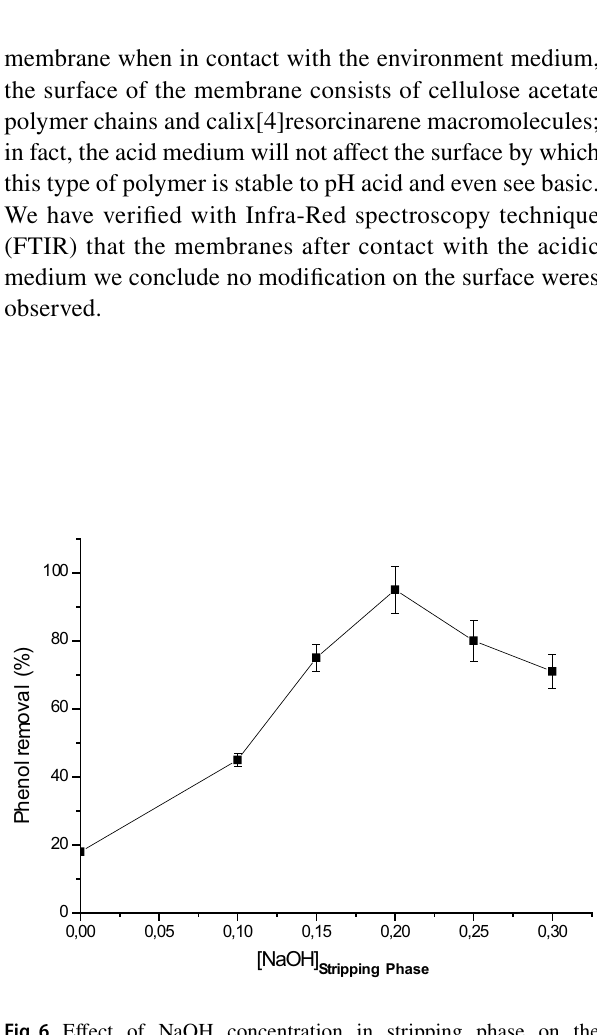
Transport conditions: feed phase: phenol 10 −3 M, pH 2. Stripping